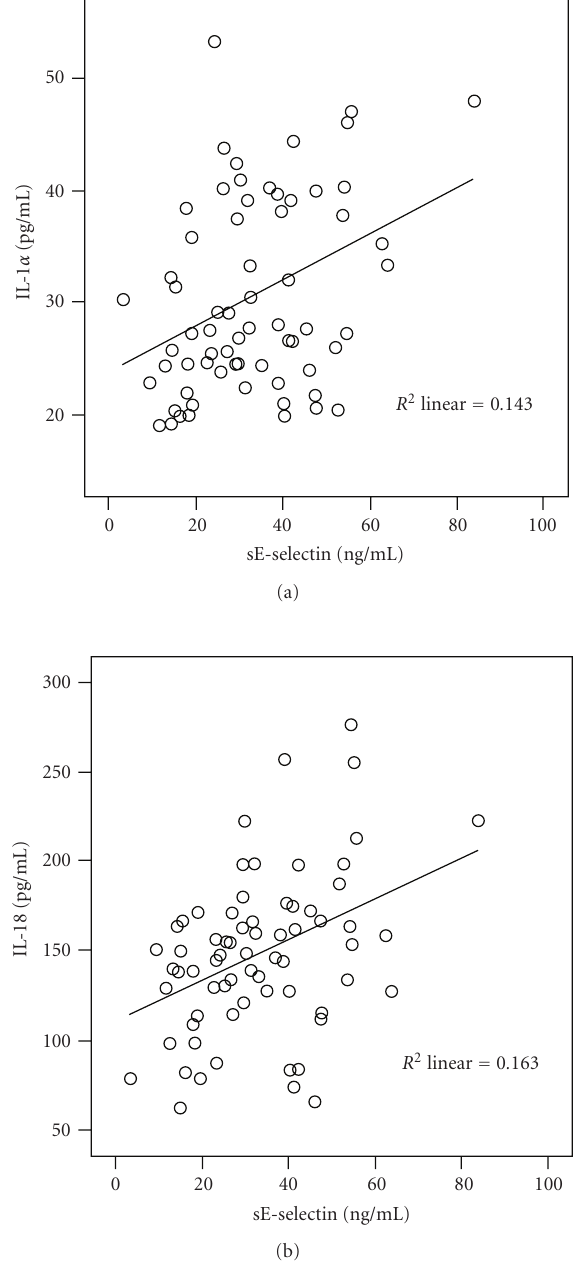
Figure 1: Association of soluble E-selectin (sE-selectin) with IL-1 α (a) and IL-18 (b). Both correlations: P < . 001.